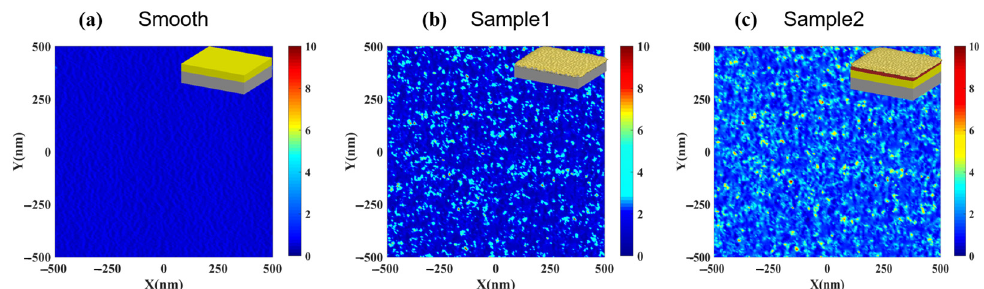
Figure 4. The simulated electric-field (|E|) distributions of the Au–Ag smooth structure without annealing ( a ) and Au–Ag composite nanostructures ( b ) and Au–Ag composite nanostructures with bottom Au mirror ( c ) under annealing temperature of 300 ◦ C. The wavelength of plane wave irradiation is 532 nm and the insets are the side view of the numerical model corresponding to the electric field diagram.